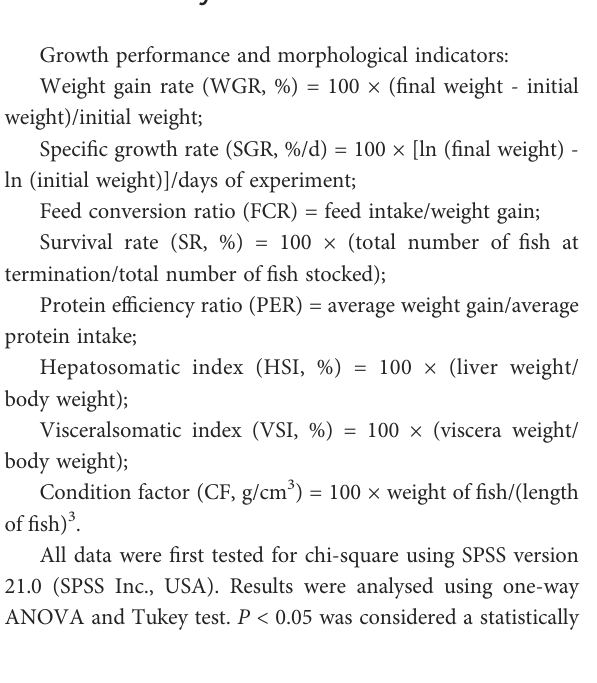
TABLE 3 Effect of dietary lipid levels on growth performance of hybrid grouper.